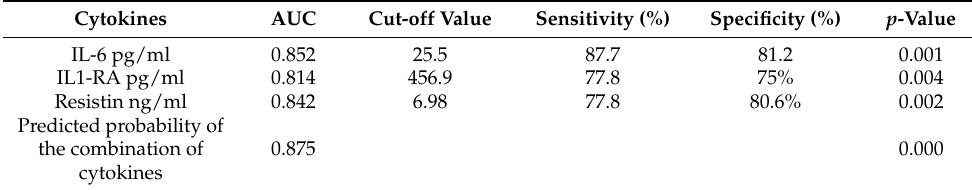
Table 7. ROC analysis—performance of MACE prediction using plasma